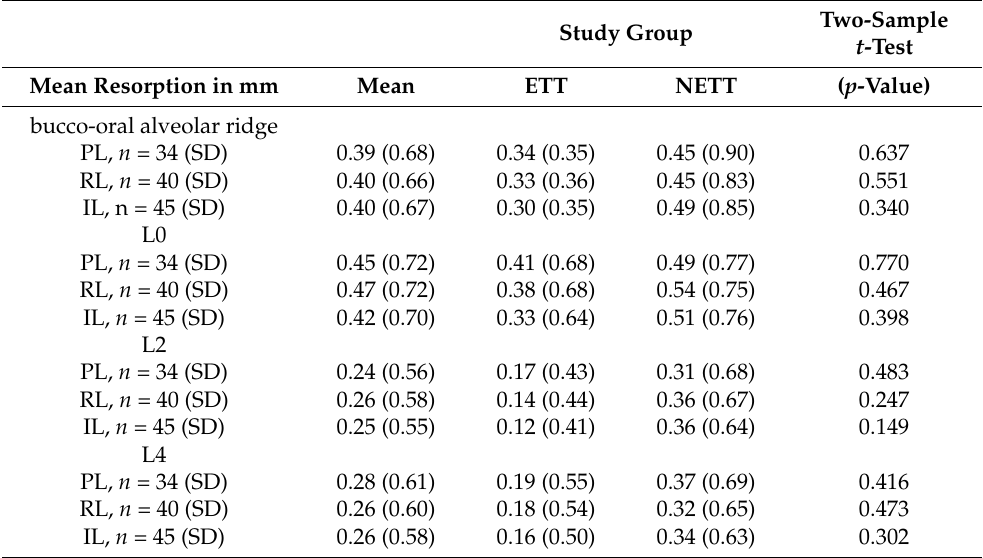
Table 4. Mean resorption of bucco-oral alveolar ridge bone width and buccal lamella bone plate from T1 to